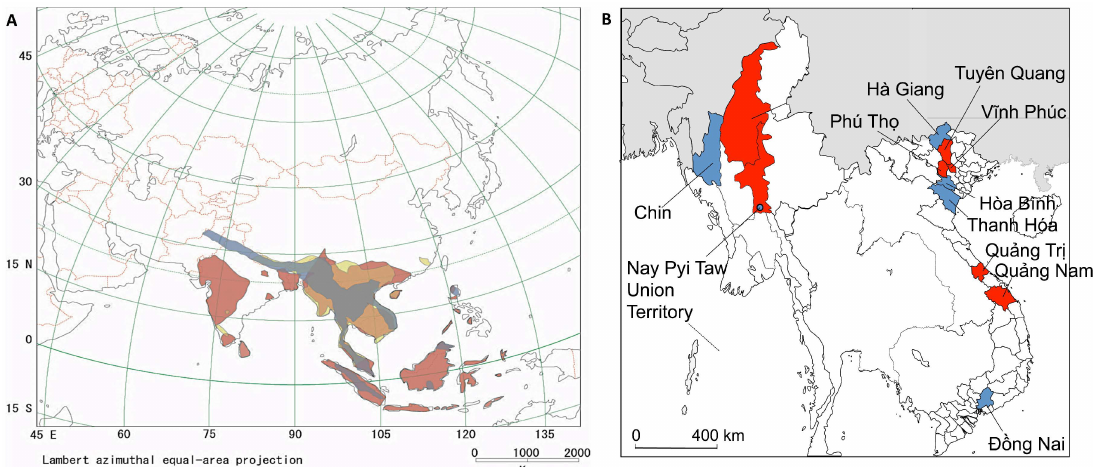
Figure 2. ( A ) Geographic distribution of the black-bearded tomb bat ( Taphozous melanopogon ) (suborder Yangochiroptera, family Emballonuridae) (colored rust), Pomona roundleaf bat ( Hipposideros pomona ) (suborder Yinpterochiroptera, family Hipposideridae) (maize), and ashy leaf-nosed bat ( Hipposideros cineraceus ) (suborder Yinpterochiroptera, family Hipposideridae) (grey). Areas of overlap between the bat species are colored brown. ( B ) Bats were captured in seven provinces in Vietnam, and three districts in Myanmar (colored red and blue). Capture sites in Vietnam and Myanmar yielding bats infected with L á ib¯ın virus and Xu â n S ơ n virus are shown in